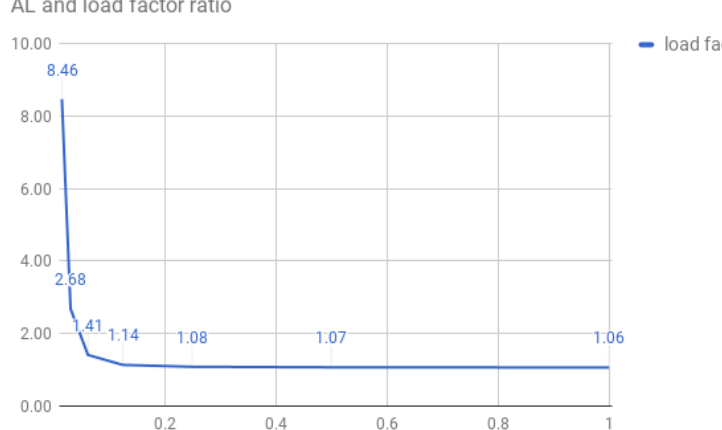
Figure 3. Accuracy level and star detection ratio. The x -axis represents the AL parameter on a logarithmic scale. The y -axis represents the ratio between all keys in the database and the candidates’ patterns (load